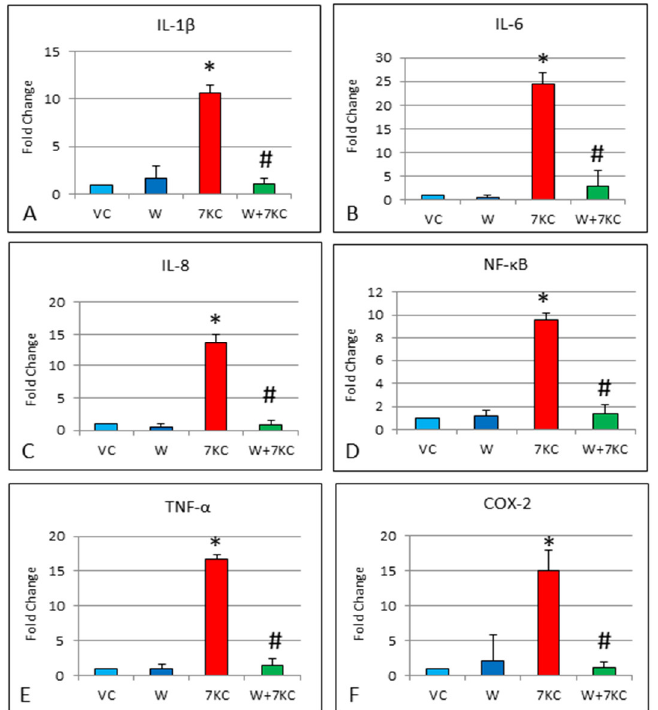
Figure 2. Effect of withanolide A on 7KC-induced increase in mRNA expression of pro-inflammatory genes, determined by real time RT-PCR. hCMEC/D3 cells were treated with vehicle only, 7KC only, withanolide A only, or pre-treated with 1 µ M withanolide A for 1 h, followed by co-incubation with 30 µ M 7KC for 24 h ( A – F ). Treatment of cells with 7KC resulted in significant induction of ( A – F ) IL-1 β , IL-6, IL-8, NF- κ B, TNF- α and COX-2 mRNA expression. These increases were significantly reduced by co-treatment with withanolide A. VC: Vehicle, W: 1 µ M withanolide A, 7KC: 30 µ M 7KC. Data are represented as mean ± SD ( n = 4). * Significant difference compared to controls. # Significant difference compared to 7KC (all p < 0.01).